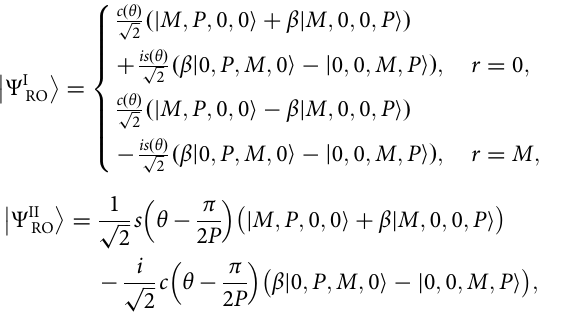
measurement probabilities at site 3 are P ð 0 Þ ¼ cos 2 P θ = 2